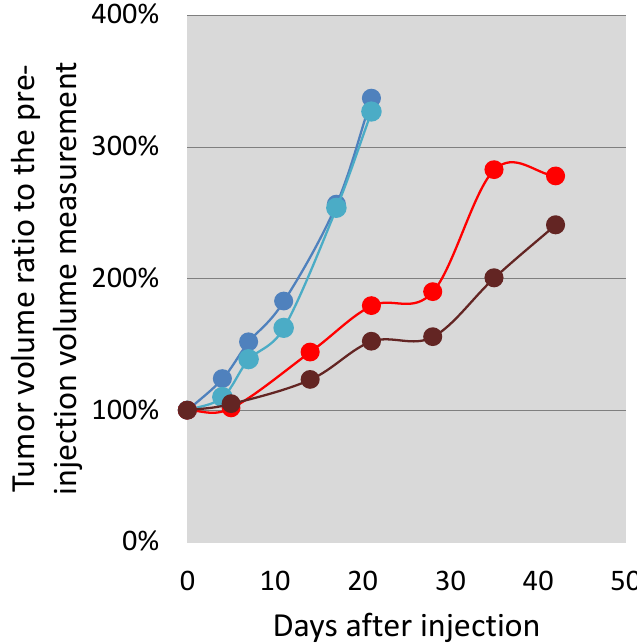
Figure 8. Follow-up of tumor volume increase in percentage of the initial tumor volume in a PC3- PSMA overexpressing cell line xenograft in two saline control (blue and turquoise) Nu/Nu nude mice, one injected intratumorally (brown) and one injected intravenously (red) with the PDC.